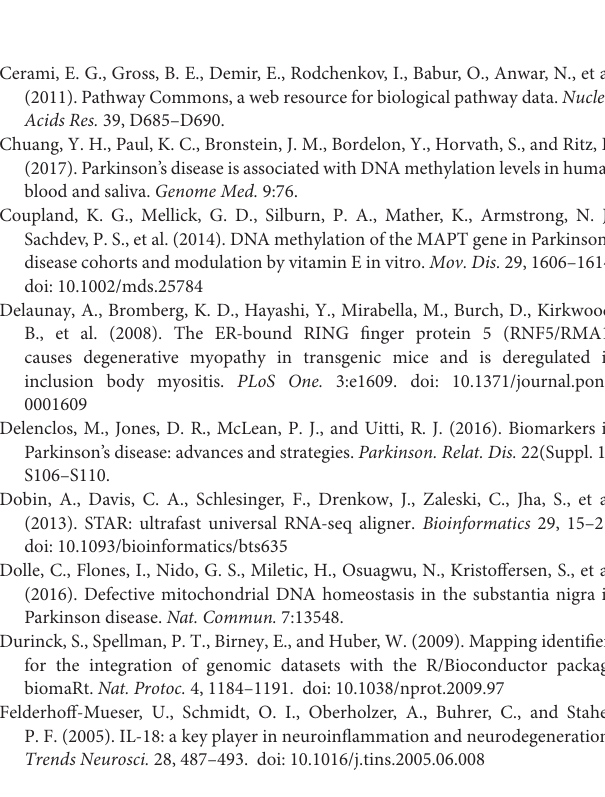
Supplementary Figure 1 | Singular value decomposition analysis plot after batch correction, showing the association of covariates with the most significant components of variation for the beta